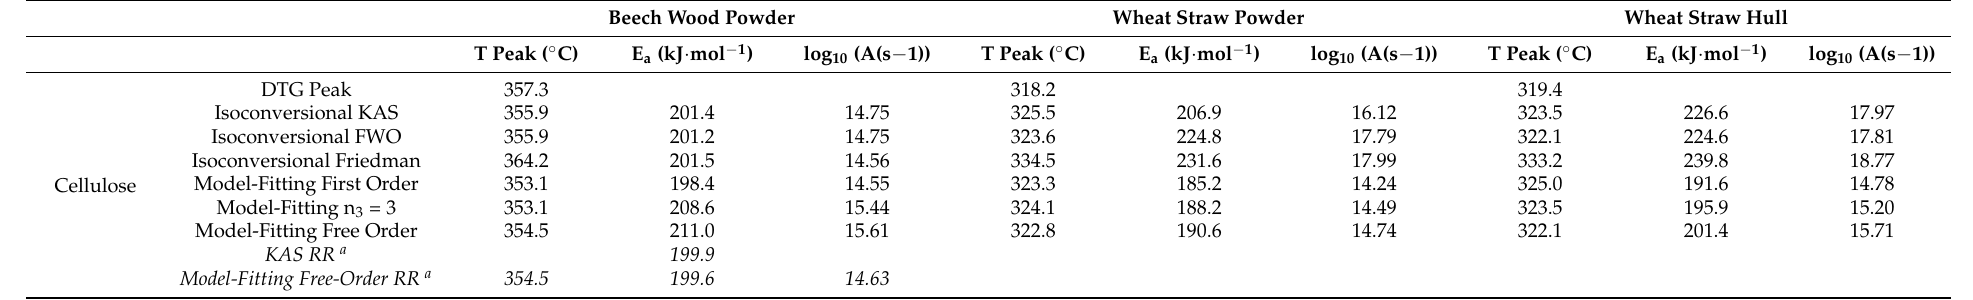
Table 8. Peak values and kinetic parameters for the different feedstocks and different methods. Cellulose peak @ 10 K · min − 1 . Order 1 to cellulose in all